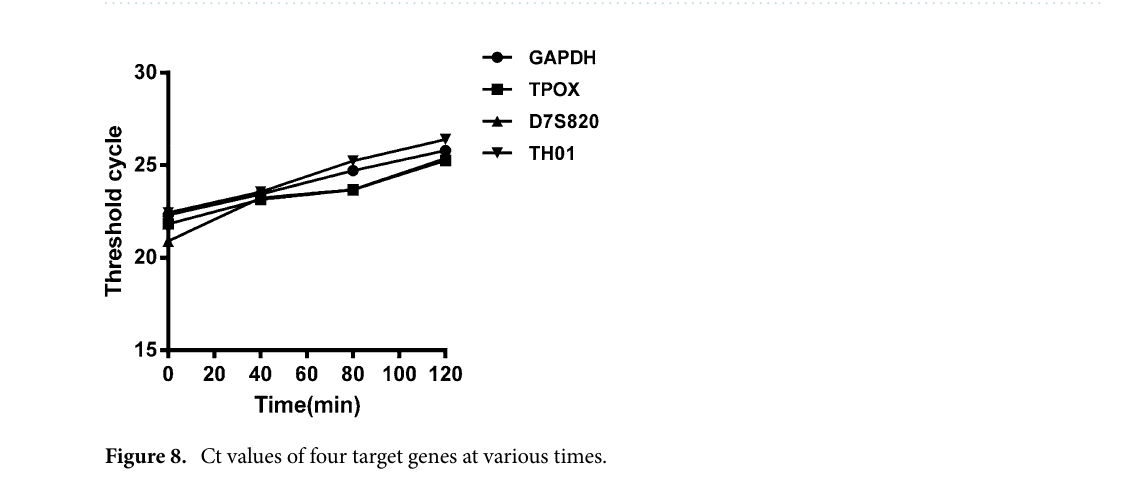
Figure 7. Electrophoresis results of GAPDH and TH01 in DNA in the mouse stomach and small intestine contents. Amplification of the TH01 (234 bp) and TPOX (79 bp) genes. Lane M: DNA marker. Lanes A1 and A2: pre-gavage (0 min). Lanes B1–B3, C1–C3 and D1–D3: post-gavage times of 40, 80 and 120 min, respectively. Lanes B1, C1 and D1: stomach content DNA bands. Lanes B2, B3, C2, C3, D2 and D3: DNA of small intestine chyme, with no DNA bands.